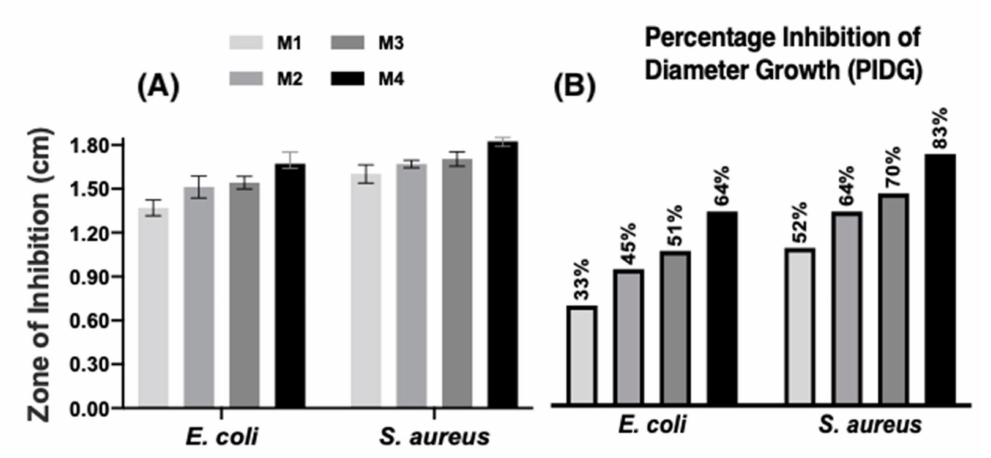
Figure 16. Histogram of comparison of the diameters of the ( A ) zone of inhibition and ( B ) PIDG, for the sample surfaces exposed to E. coli and S. aureus on agar for 24 h at 37 ◦ C in an incubator (dark